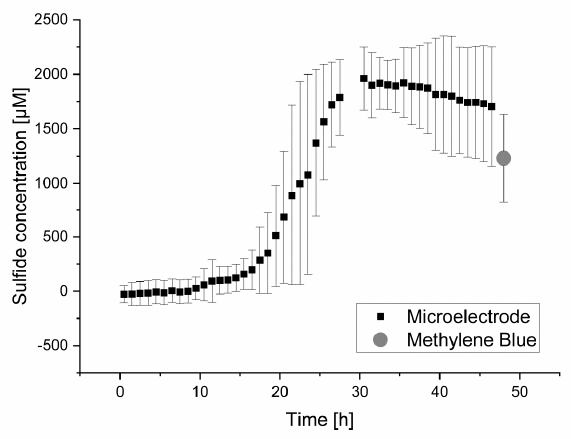
Figure 6. Microbial sulfide emission in AWW 2 at RT traced by gold amalgam microelectrodes (GAME) and the Methylene Blue method (for six separately performed replicate experiments).